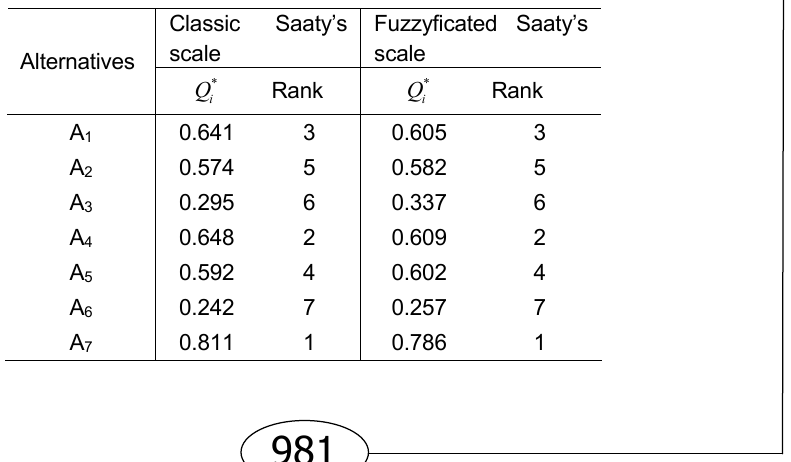
Table 6 – Comparative summary of the solutions with the change of the initial elements Таблица 6 – Сравнительный обзор решений с изменением исходных